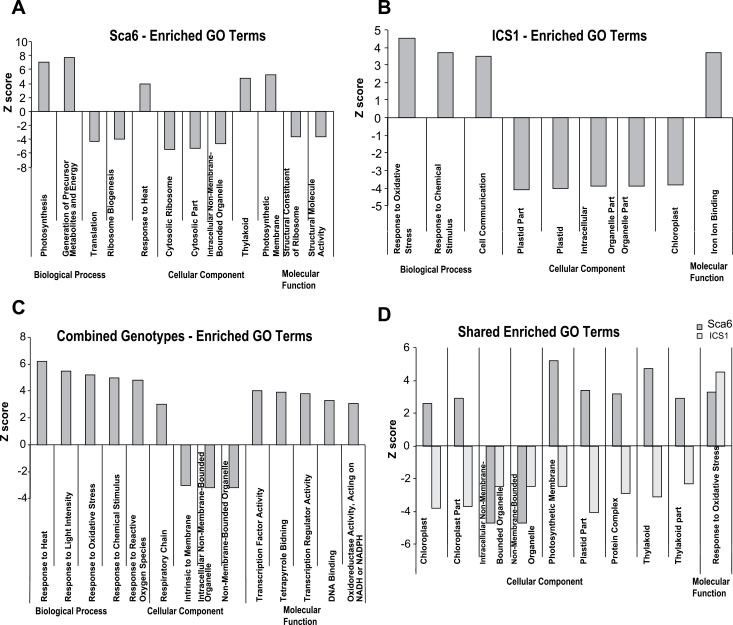
GO enrichment by parametric analysis of gene set enrichment (PAGE). Z scores of select GO terms calculated using PAGE on statistically significantly differentially regulated genes in (A) Sca6, (B) ICS1, and (C) averaging both genotypes across all stages. (D) Z scores of select GO terms with statistically significant enrichment in both genotypes. Detailed data are provided in Supplementary Tables 5−9.